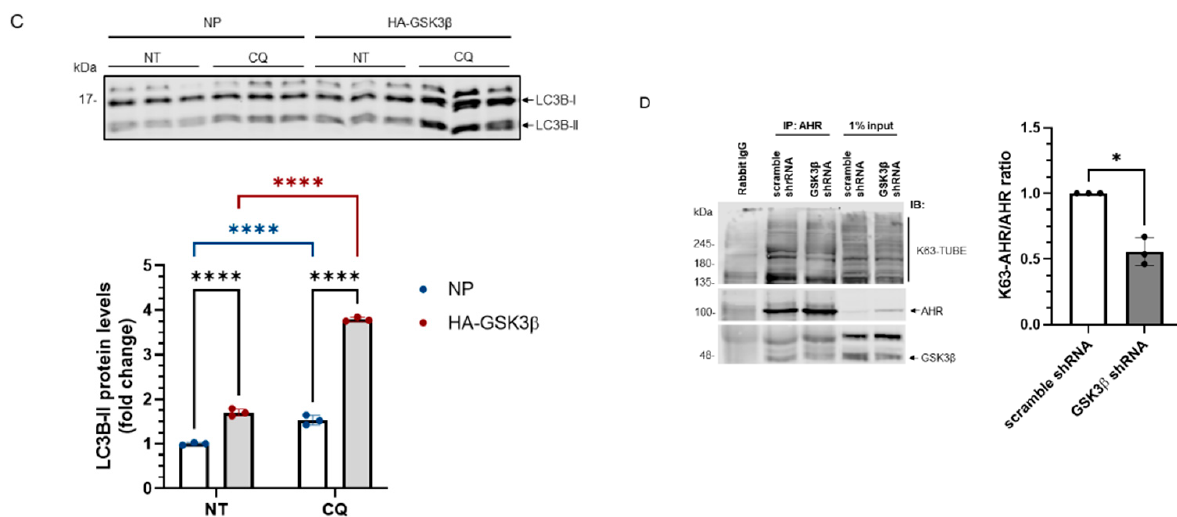
Figure 3. AHR undergoes the LC-3-mediated autophagy after GSK3 β phosphorylation. ( A ) AHR protein levels ± HA-GSK3 β transient expression (72 h) were increased by CQ (40 µ M for 6 h, last 6 h of the 72-h period of transient transfection) but not by MG132 (10 µ M for 6 h, last 6 h of the 72-h period of transient transfection). The time and dose of CQ and MG132 were optimized for inhibition of degradation. The images are representative of the replicate data (means ± SD, n = 3, ** p < 0.01, **** p < 0.0001, ns represents not significant) in one experiment and was repeated once with similar results. DMSO treatment group (treated for 6 h) was arbitrarily set as one for data normalization. No plasmid (NP) group represents cells undergoing the same transient transfection as HA-GSK3 β but without plasmid. Two-way ANOVA with Dunnett multiple comparisons test was performed to determine statistical significance. ( B ) β -catenin protein levels decreased after HA-GSK3 β transient expression (72 h) and were increased ± HA-GSK3 β by MG132 (10 µ M for 6 h, last 6 h of the 72-h period of transient transfection). The images are representative of the replicate data (means ± SD, n = 5, ** p < 0.01, *** p < 0.001, **** p < 0.0001). DMSO treatment group was arbitrarily set as one for data normalization. No plasmid (NP) group represents cells undergoing the same transient transfection as HA-GSK3 β but without plasmid. Two-way ANOVA with Sidak multiple comparisons test was performed to determine statistical significance. ( C ) LC3B-II levels with HA-GSK3 β transient expression (72 h) were higher than that in the no plasmid group (NP). No plasmid (NP) group represents cells undergoing the same transient transfection as HA-GSK3 β but without plasmid. The fold change of LC3B-II increase after 6-h, 40 µ M CQ treatment was also higher in the HA-GSK3 β group. The images are representative of the replicate data (means ± SD, n = 3, **** p < 0.0001) in one experiment and was repeated once with similar results. No treatment (NT) group (treated for 6 h) was arbitrarily set as one for data normalization. Two-way ANOVA with Tukey multiple comparisons test was performed to determine statistical significance. ( D ) Immunoprecipitation of AHR from HeLa whole cell lysates ± GSK3 β knockdown using anti-AHR SA210 polyclonal antibody, followed by K63-TUBE Far-western analysis showing less K63-ubiquitinated AHR in GSK3 β knockdown group while more AHR (104 kDa) being precipitated when compared to the scramble shRNA-transfected group. The images are representative of the replicate data (means ± SD, n = 3, * p < 0.05) with scramble shRNA group set as one for normalization of three separate experiment (thus no error bar). For A to C, each Western lane contained 30 µ g of whole-cell lysate. Data were normalized by total protein